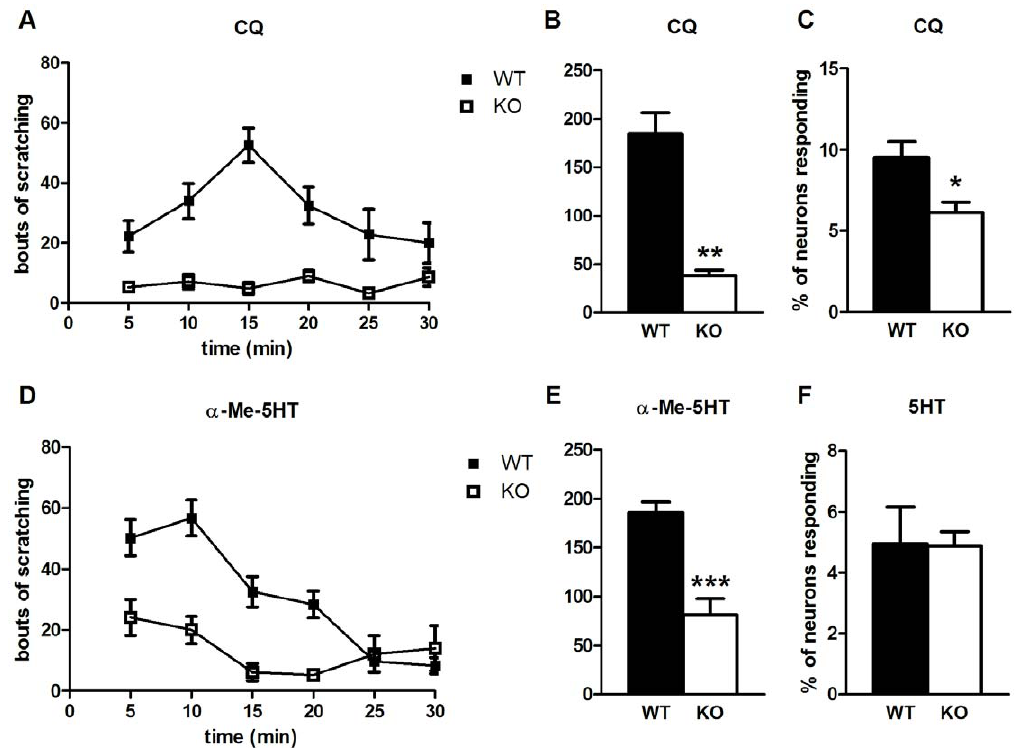
Figure 2. Nonhistaminergic itch requires Pirt. ( A , B ) CQ (200 m g) induces significantly less scratching behavior in Pirt 2 / 2 mice (n=9) than WT controls (n=8). ( C ) A smaller percentage of Pirt KO neurons respond to CQ (1 mM) compared to WT (n=5 per genotype). ( D , E ) The 5HT 2 -selective agonist a -Me-5HT (30 m g) produces decreased scratching in KO mice (n=8; WT, n=13). ( F ) Responses to 5HT (10 m M) are unchanged in Pirt KO DRG neurons (n=4 per genotype). * p , 0.05, ** p , 0.001, *** p , 0.0001; two-tailed unpaired t